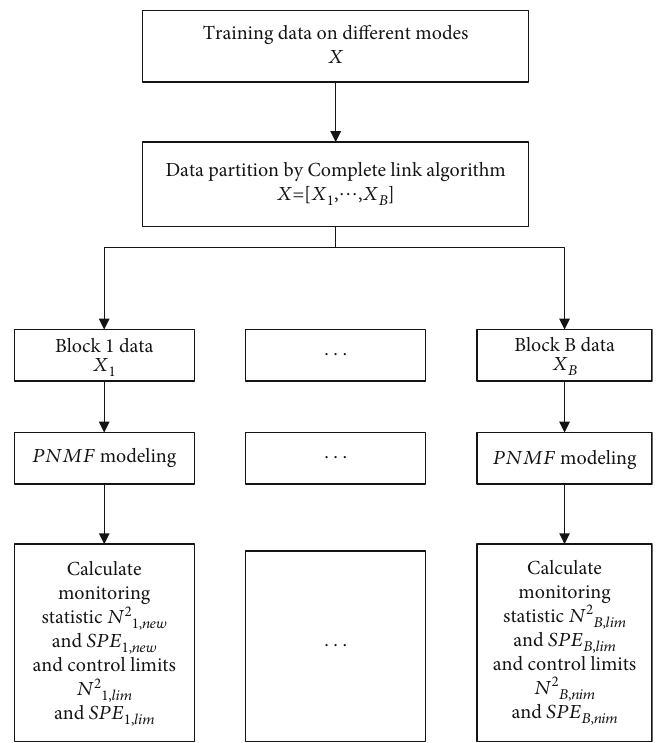
Figure 1: O ffl ine modeling fl ow